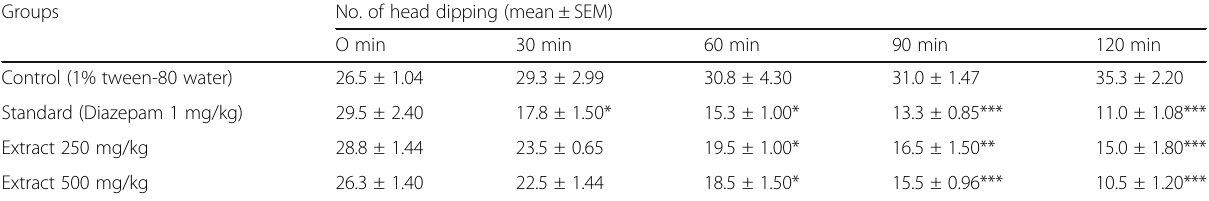
Table 4 Neuropharmacological effect of Lepisanthes rubiginosa L. on mice in Hole Board method Groups